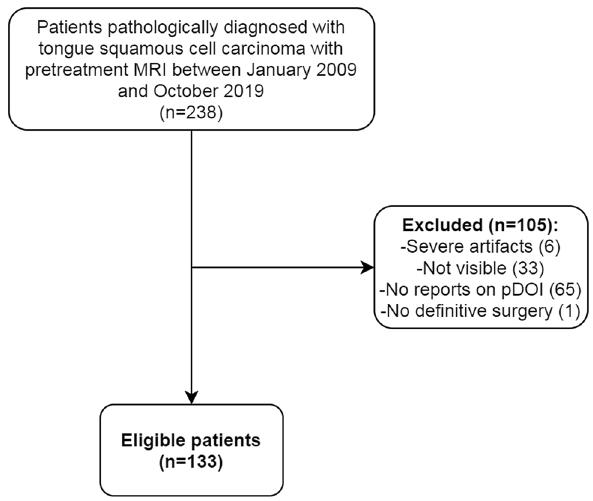
Figure 1. A flowchart presenting the patient selection